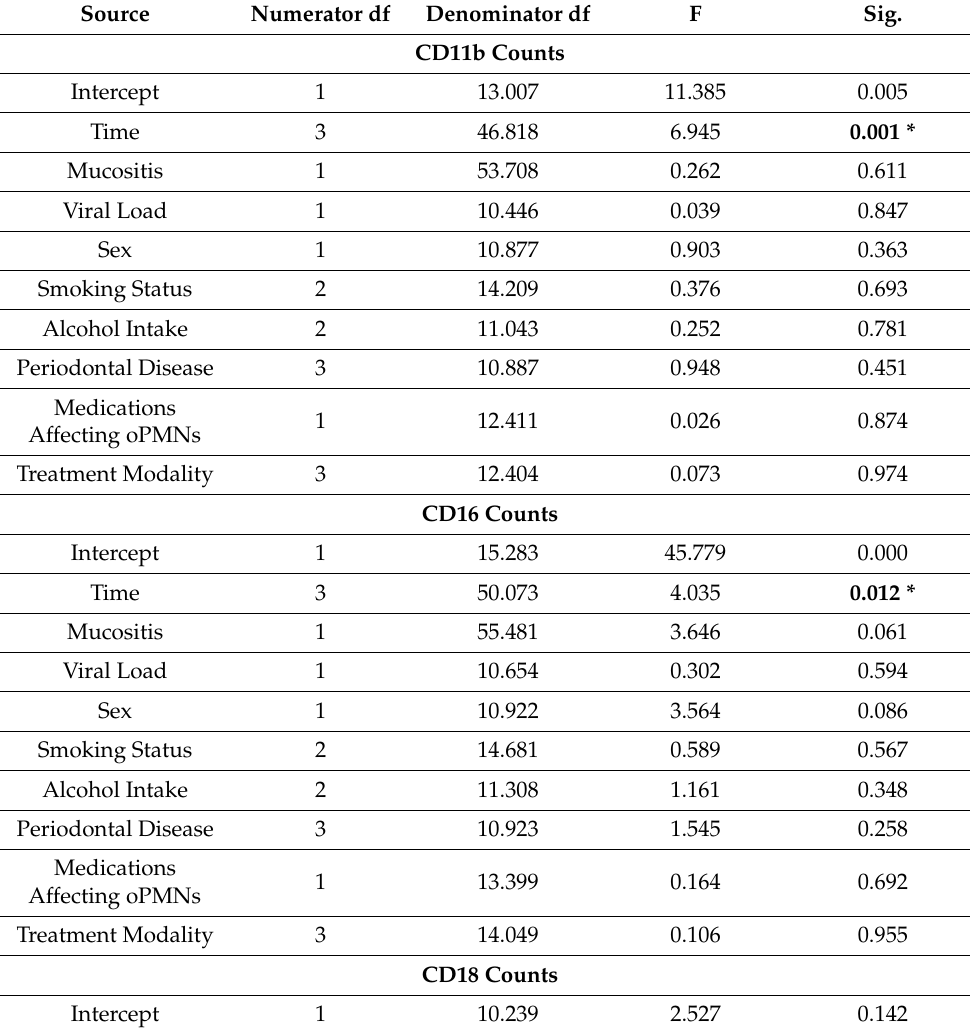
Table A10. Statistically significant results of the LMM analyses for oPMN marker fold-changes for CD11b, CD16, 1CD8 CD64 and